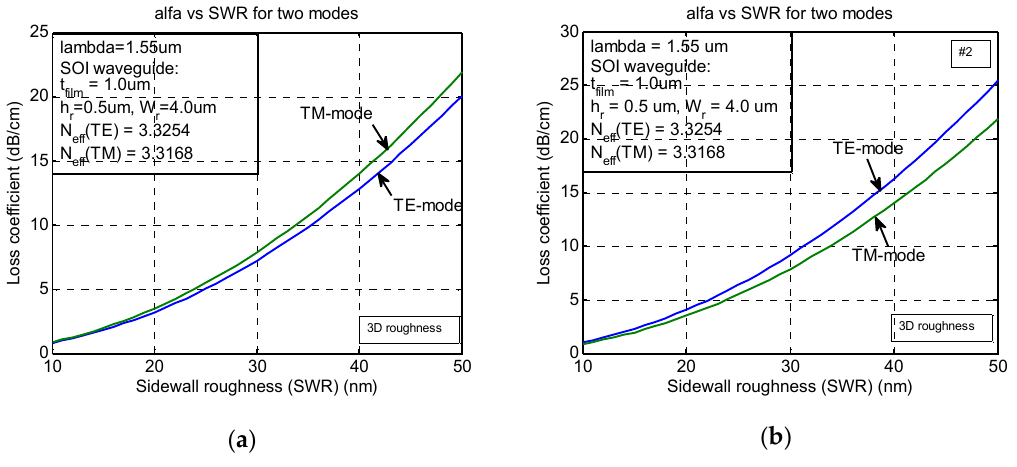
Figure 4. Simulations for the optical loss coefficient of SOI waveguide vs. SWR for two SWR constructions: ( a ) the 2D SWR, ( b ) the 3D-SWR.